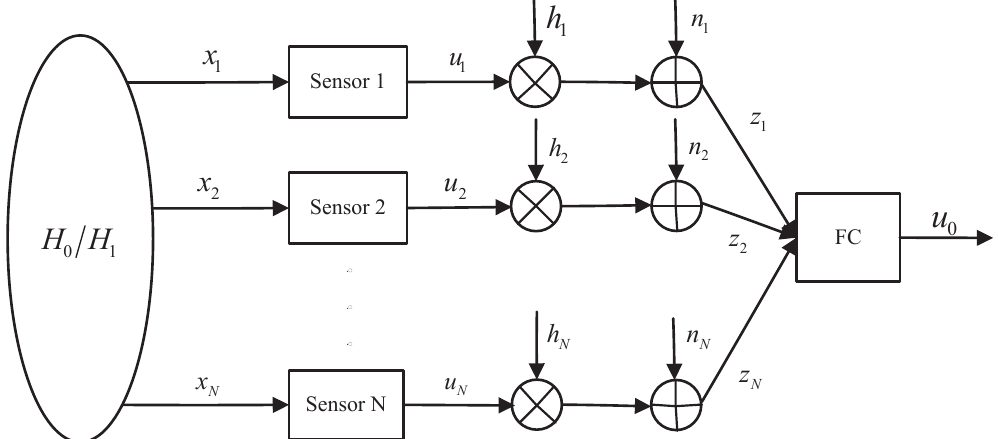
Figure 1. A block diagram of the parallel fusion model in the presence of fading and noisy channels between sensors and the fusion center